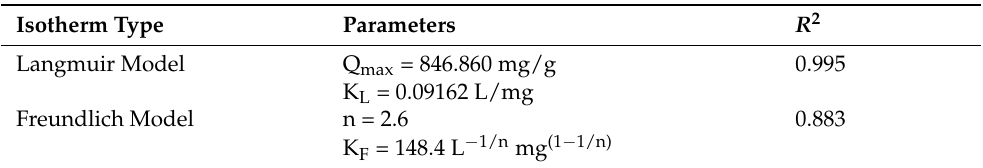
Table 1. Calculated parameters for the adsorption isotherm fittings for the Ag/Fe 3 O 4 nanocomposites.